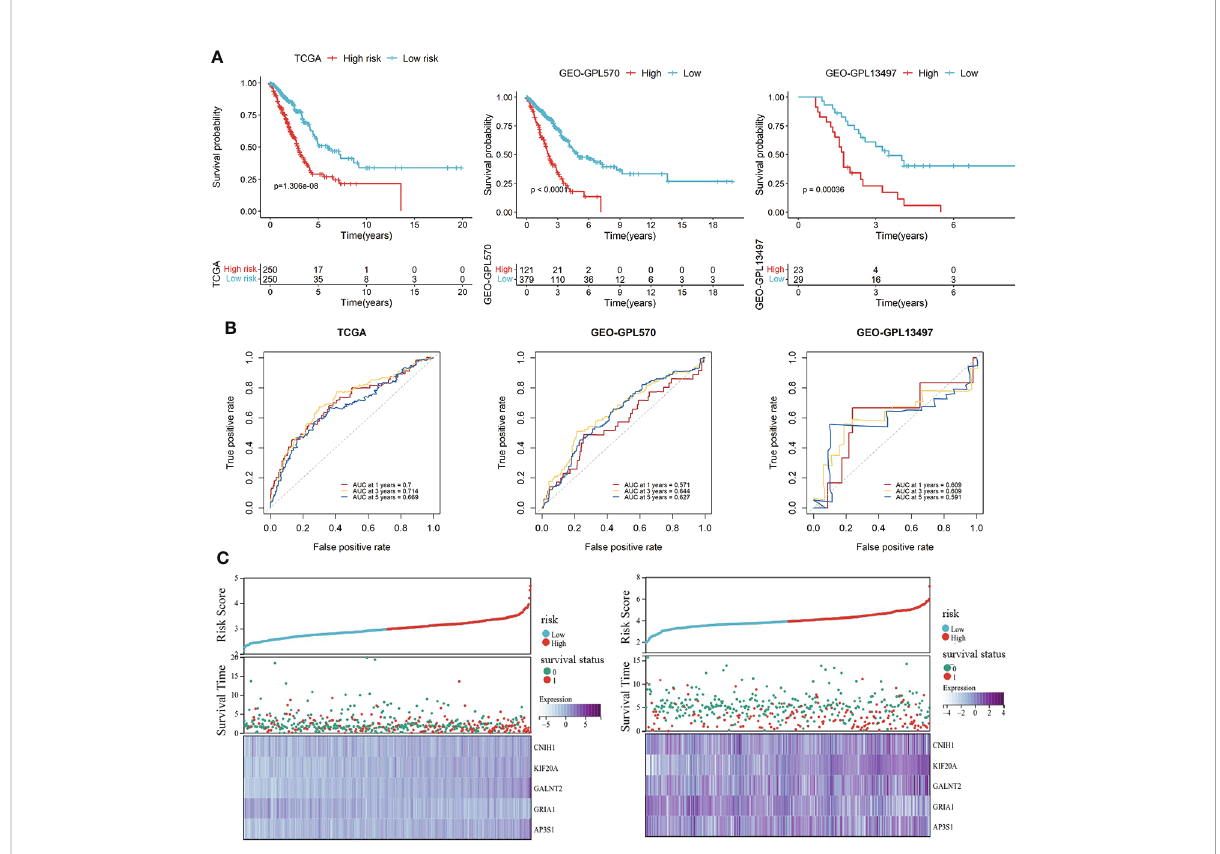
FIGURE 3 Development and validation of a vesicle-mediated transport-related gene prognostic model. (A) Survival analysis of high- and low-risk groups in the TCGA set (left), GEO datasets of GPL570 (middle), and GEO datasets of GPL13497 (right). (B) Time-dependent ROC curve analysis of the prediction model in the TCGA and GEO -GPL570 datasets. (C) Distribution of expression pro fi les of 5 hub genes, the risk score, and survival status in TCGA and GEO